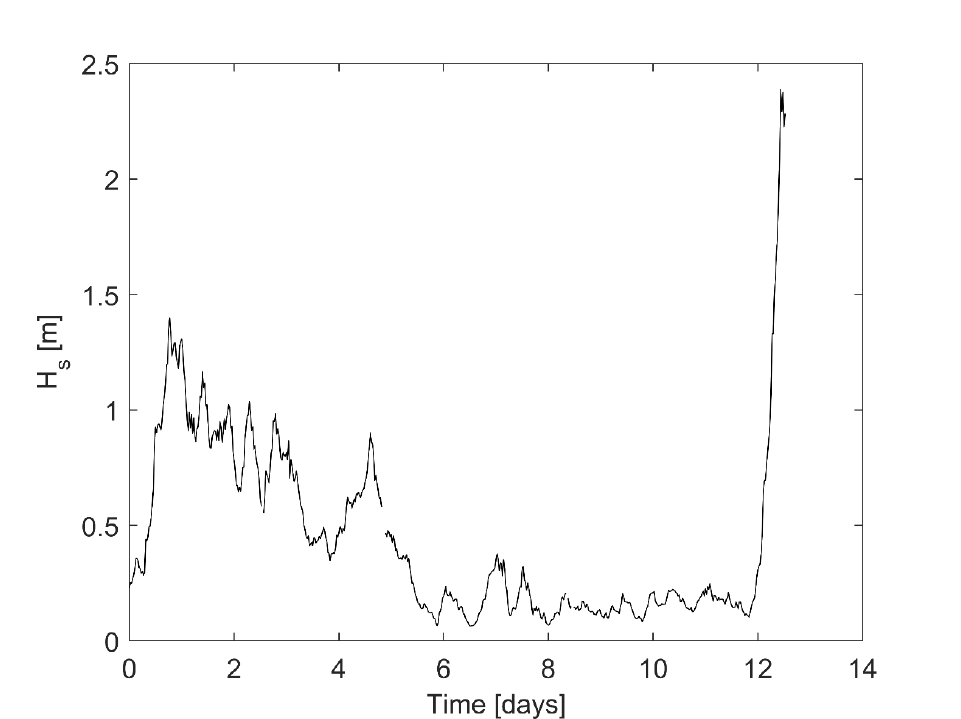
Figure 3. Significant wave height for the period of the experiment. Data measured at the test site by Uppsala University’s wave measurement